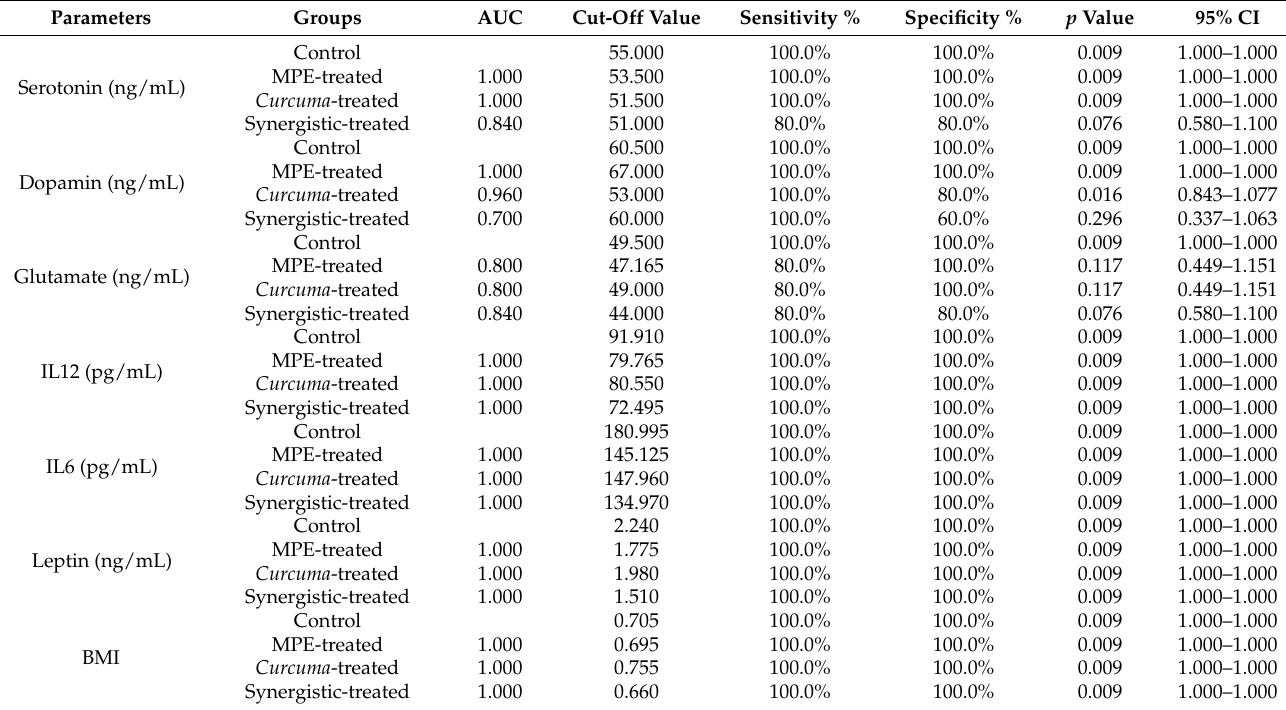
Table 5. ROC-Curve of all parameters for